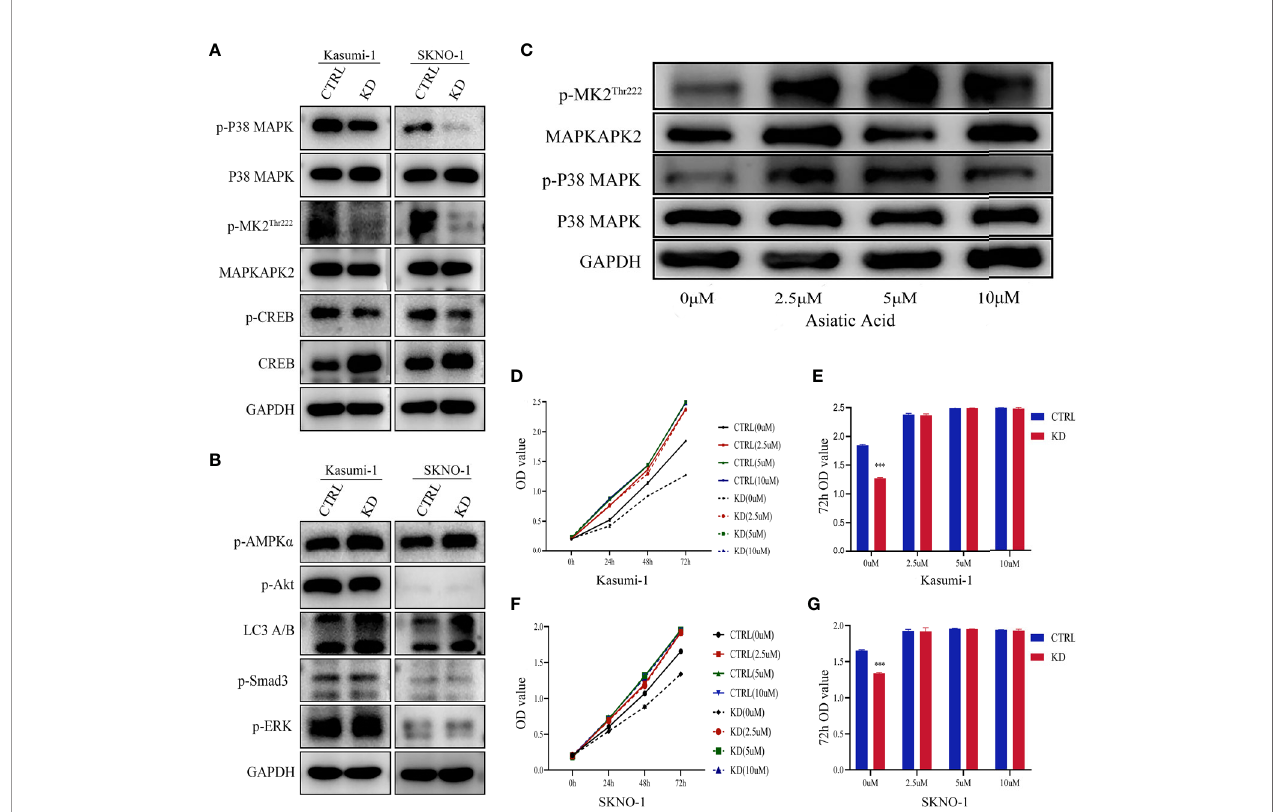
FIGURE 5 | P38 MAPK pathway is critical for GNA15-mediated alterations. (A) Western blot analysis of P38 MAPK pathway in GNA15-KD cells and controls. (B) Western blot analysis of other proliferation- and metabolism-related proteins in GNA15-KD cells and controls. (C) The upregulation of P38 MAPK signaling pathway by Asiatic Acid (P38 MAPK activator) in GNA15-KD cells of Kasumi-1. (D, F) Asiatic Acid (2.5 m M, 5 m M, 10 m M) reversed the inhibitory effect of GNA15 knockdown on the proliferation of Kasumi-1 (D) and SKNO-1 (F) . (E, G) Asiatic Acid (2.5 m M, 5 m M, 10 m M) reversed the inhibitory effect of GNA15 knockdown on the proliferation of Kasumi-1 (E) and SKNO-1 (G) at 72h. CTRL, control; KD, knockdown; p-MK2 Thr222 : p-MAPKAPK2 Thr222 ; *** P < 0.001 compared with CTRL cells; Error bars indicate the standard